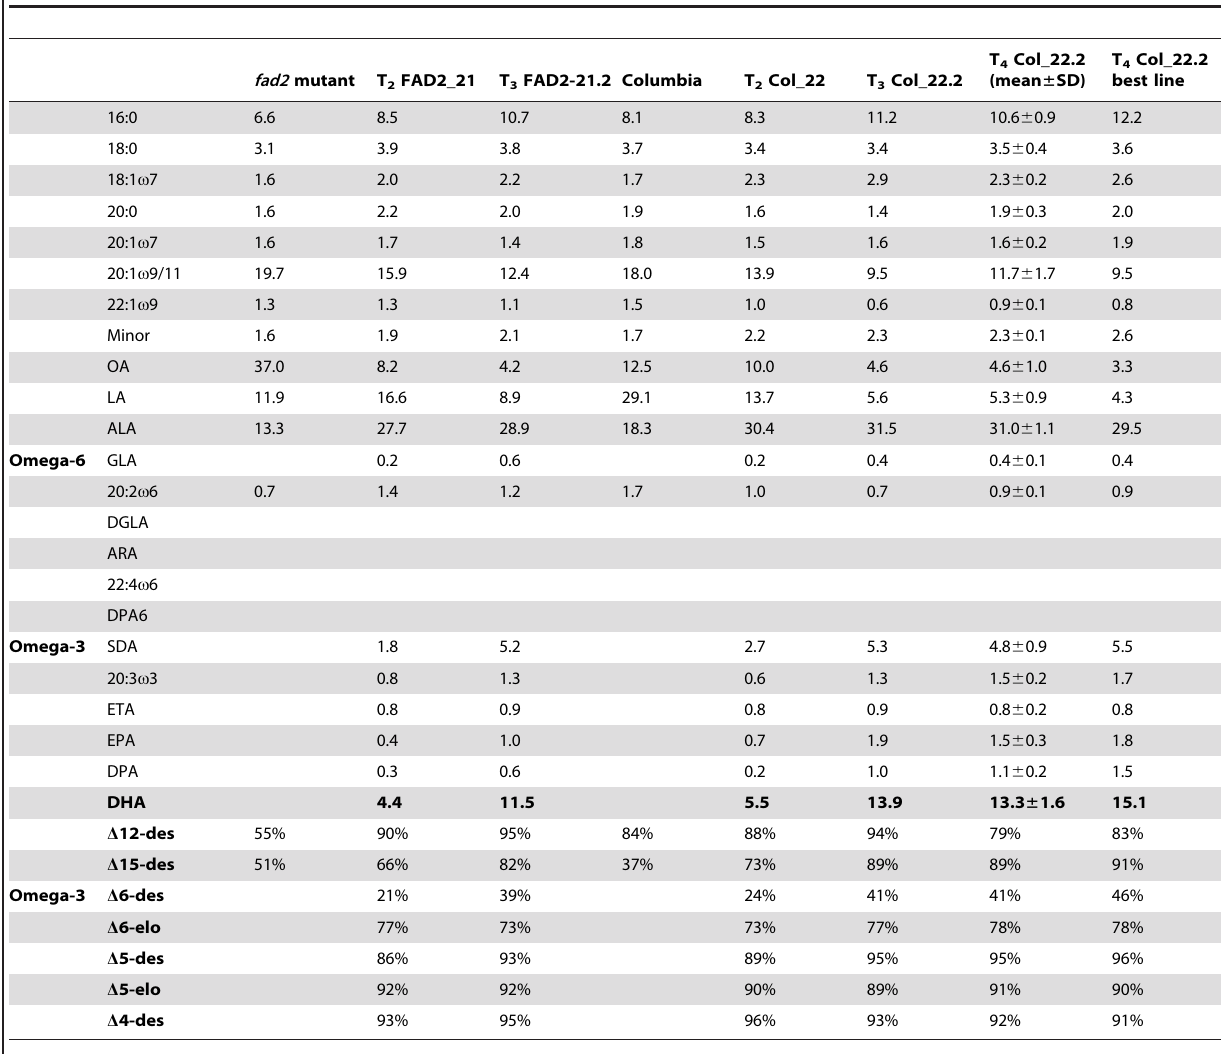
Table 1. Representative fatty acid profiles of total pooled seed lipids from independent transgenic parental, T 2 , T 3 and T 4 Arabidopsis lines with the highest DHA